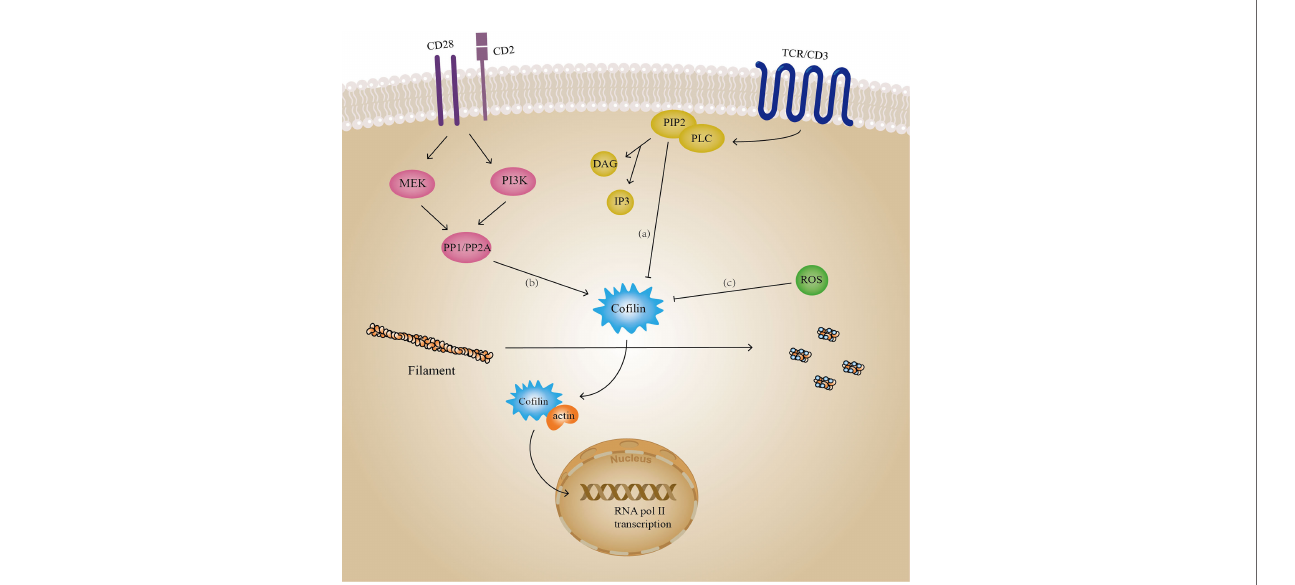
FIGURE 6 | Co fi lin involves in T cell signaling. Several signaling pathways in T cells contain co fi lin, including: (A) PLC-PIP2 pathway belonging to the TCR signaling, (B) protein phosphorylation belonging to co-stimulation signaling, and (C) protein oxidation. Activated co fi lin can mediate actin entry into the nucleus and play a regulatory role in gene transcription. PP1/PP2A: protein serine/threonine phosphatases of type 1 and type 2A, ROS, reactive oxygen